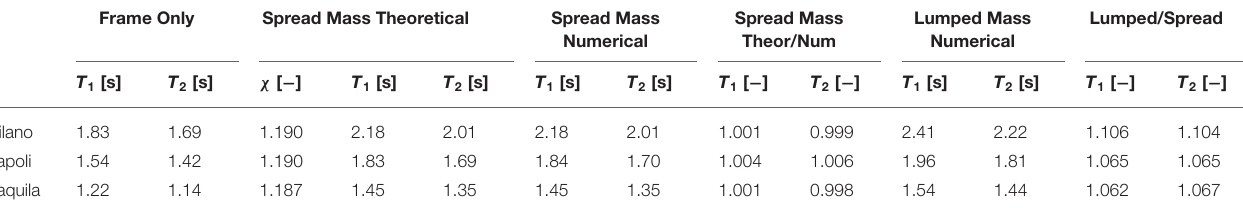
Spread Mass Lumped Mass Numerical Theor/Num Numerical